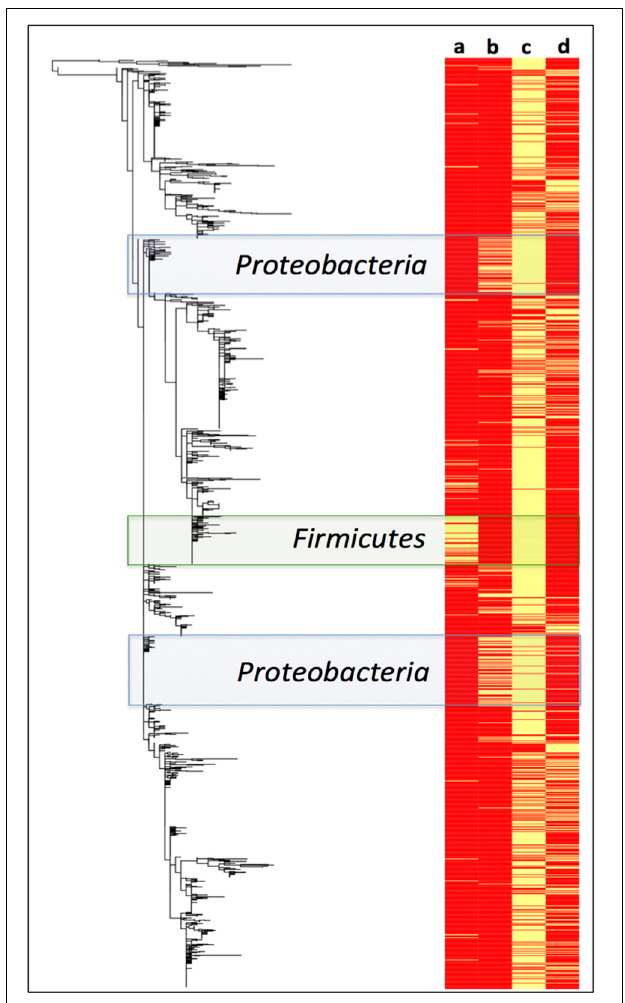
FIGURE 6 | Maximum likelihood phylogenetic tree of Paaratte Formation sequences displayed with its metadata. Yellow bars on the heatmap indicate that the associated external node is an OTU that has been described to carry the genes associated with the expression of a (a) carbon monoxide dehydrogenase (CODH; green highlight), and a (b) polyethylene glycol dehydrogenase (PEGDH; blue highlight). Metadata also indicate if the external node is associated with the (c) pre-scCO 2 injection phase or the (d) post-scCO 2 injection phase. PyNAST aligned sequence data were used to construct the phylogenetic tree using the Maximum Likelihood algorithm on